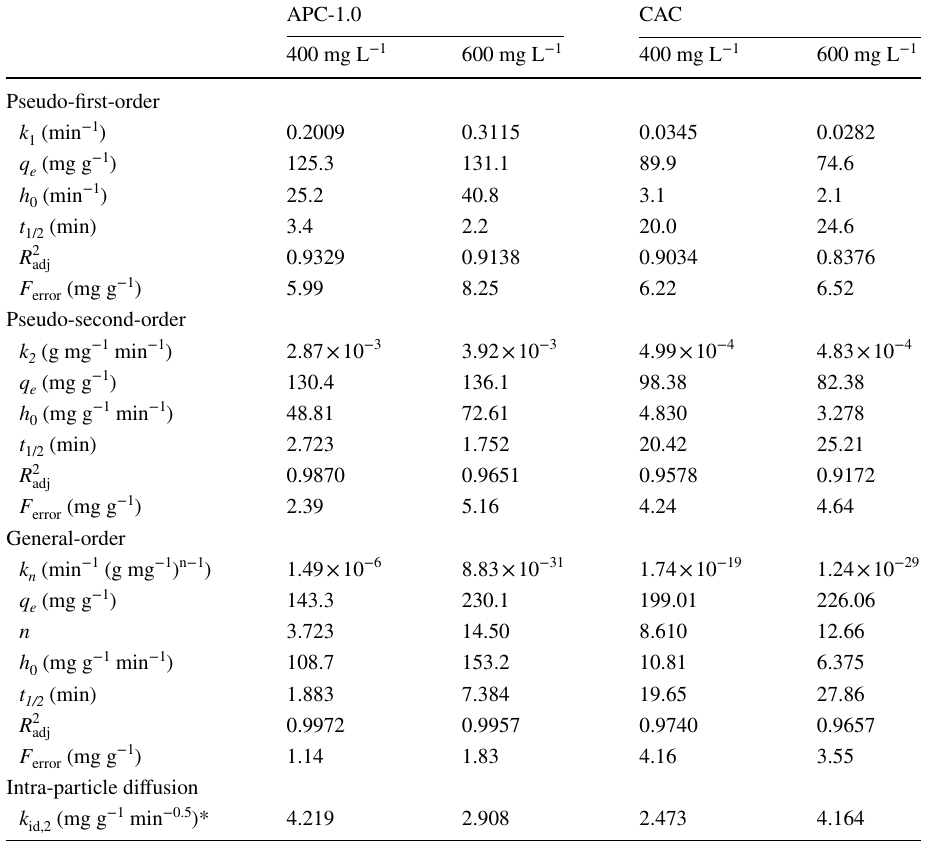
Table 2 Kinetic parameters PR-5B dye adsorption onto APC-1.0 and